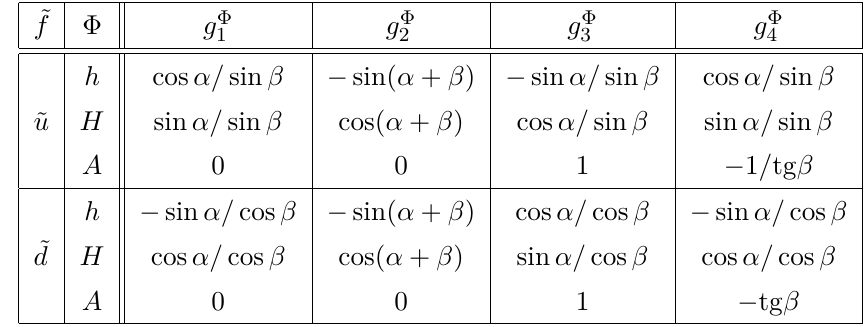
Table 1 . Coefficients of the neutral MSSM Higgs couplings to sfermion pairs. The symbols ˜ u, ˜ d denote up- and down-type